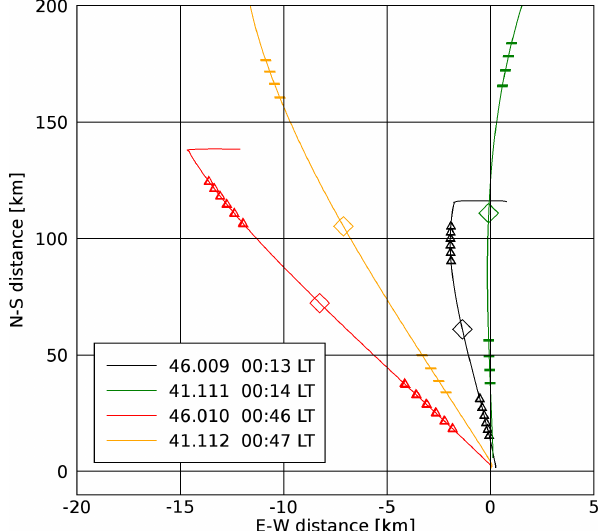
Figure 1. Horizontal projection of the four sounding rocket trajec- tories. The triangles mark altitudes 70 to 120km in 10km steps on upleg and downleg for the instrumented payloads (MTeX 46.009 and 46.010), and the dashes mark altitudes 90 to 120km for the chemical tracer payloads (MIST 41.111 and 41.112). The diamonds mark the apogees.